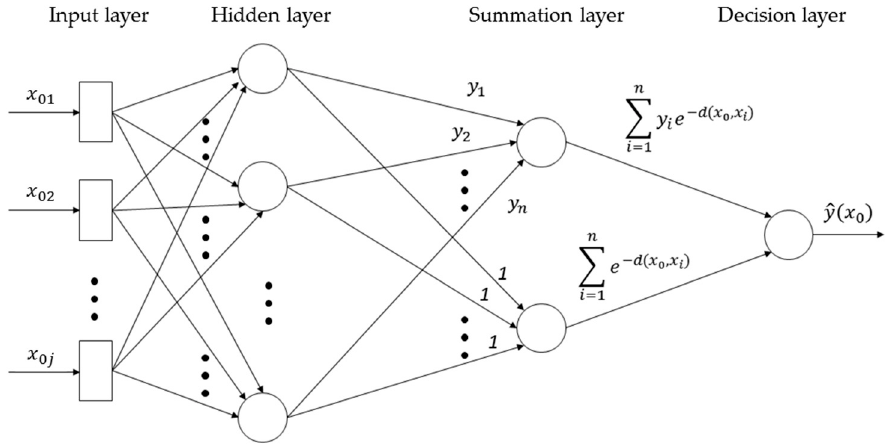
Figure 3. Schematic diagram of the generalized regression neural network architecture based on Cigizolu and Alp [30].